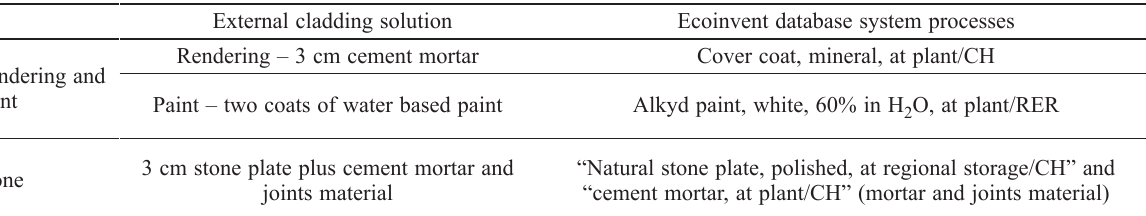
table 6. Characteristics of each external wall cladding and the ecoinvent system processes used in the lCA